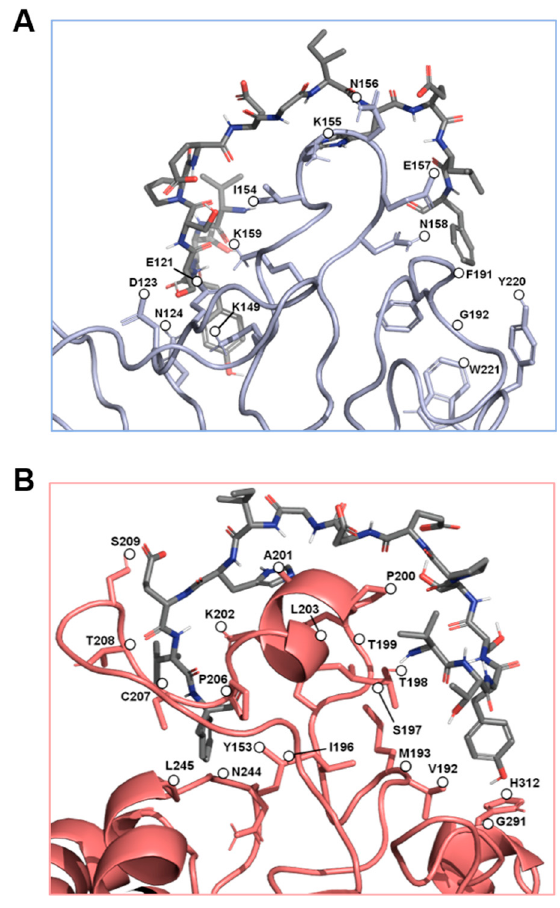
Figure 3. The predicted key binding amino acids of the triple loop structures from the α 4 and β 1 subunits. The amino acids with the highest predicted binding affinities to the EDA-FN peptide (grey) are highlighted within ( A ) the α 4 subunit triple loop finger-like domains of the integrin receptor cleft (blue), and ( B ) the β 1 subunit triple loop finger-like domains of the integrin receptor cleft (red). The β 1 subunit was used for visualization. Table 1. Predicted integrin α 4 β 1 / β 7 amino acids with contact with the EDA-FN peptide. Mode